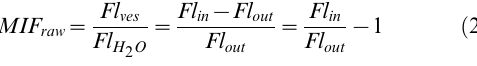
Figure S1. Cl 2 concentration was held at 155 mM and Na + and K + concentration at 162 mM, the log P values were equally weighted by three methods (VG, KLOP, and PHYS), and tautomerization and resonance were considered.